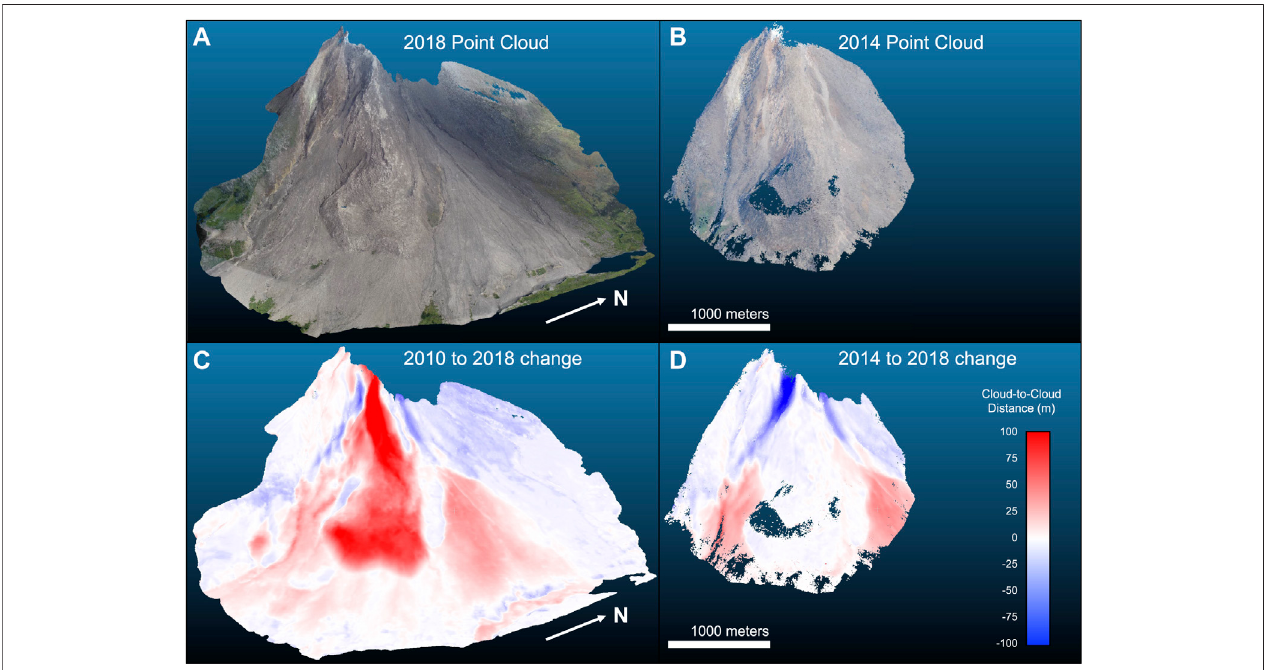
FIGURE5| Thickness oferuptiondeposits at Sinabung.A 3Doblique viewofthepoint clouds generatedbySfM photogrammetry from thesurveys ofSinabungin 2018 (A) and2014 (B) .TheUASsurveyin2018allowedforincreasedpointdensityandcoveragecomparedtotheground-based2014survey. (C) Theeruptiondeposit thicknesscreated bydifferencingthe2010pointcloudfromthe2018pointcloud.PDCdepositsoneithersideofthelava fl owexceed50 minthickness. (D) Thechange ineruptivedepositthicknessbetweenthe2014and2018pointclouds.Theregionofthelava fl owthatcollapsedin2014 – 2015,removingover100 mofmaterialin some places, is clearly visible (dark blue). The 3D perspective and scale are identical for all four